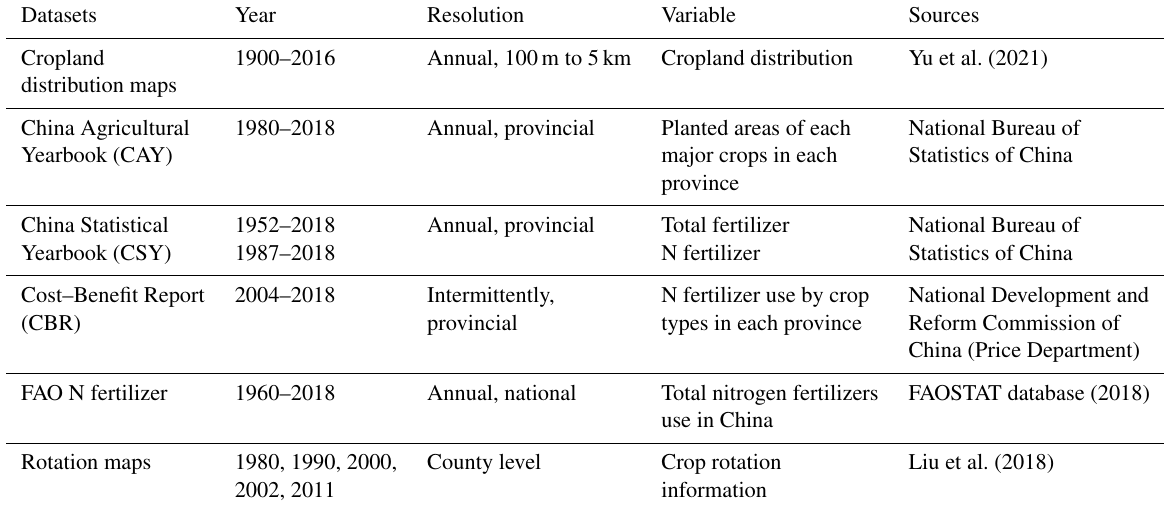
Table 1. Datasets used for nitrogen (N) fertilizer use reconstruction. Datasets